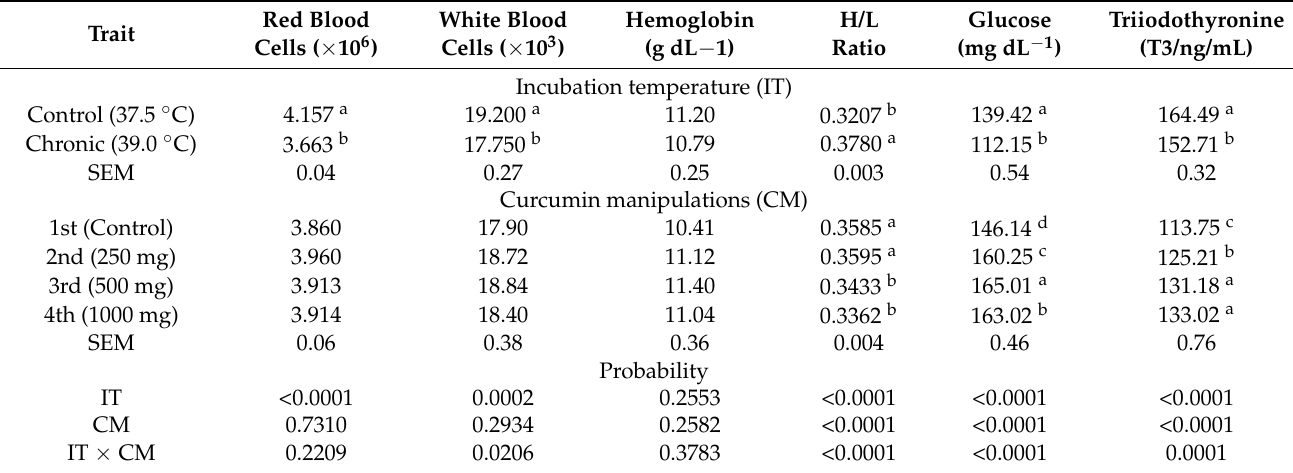
Table 4. Impact of incubation temperature, curcumin manipulations and their interaction on hematological parameters, glucose level and T3 hormone concentration in newly-hatched